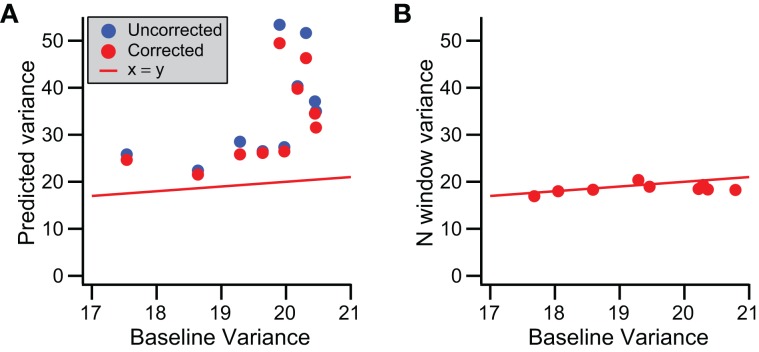
Prediction of baseline variance during CS. (A) Scatter plot of predicted baseline variance, obtained by extrapolating the regression line between number of spikelets and the spikelet-related variance to zero spikelet, vs. baseline variance measured from times surrounding the CS (outside the T window). The predictions were made from regression lines with either σ2T (uncorrected, blue) or σ2T* (corrected, red circles) vs. spikelet number. (B) Scatter plot of σ2N vs. measured baseline variance. Red line indicates y = x in both (A,B).